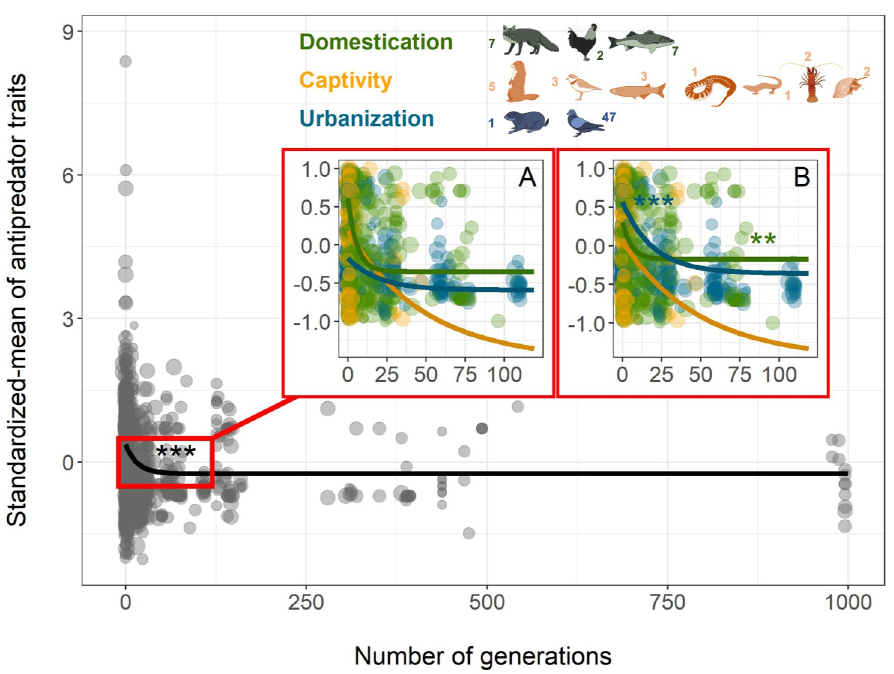
Fig 1. In multiple species, interactions with humans reduce the overall mean of antipredator traits over time, black line (all contexts). (A) Lines correspond to the best inverse model fitting the data using the cma-es function. (B) Lines correspond to the best inverse model with the outputs (slopes and intercepts) of the MCMCglmm model for the mean. Dot size is proportional to the log-transformed number of replicates used in each study. “ ��� ” indicates significant p -value < 0.001 and “ �� ” significant p -value < 0.01 of the inverse slopes with the MCMCglmm model (S1 Table). The number associated with each animal indicates the number of species in each of the following taxa: Mammals, Birds, Reptiles, Fish, Amphibians, Arthropods, and Mollusks. All data and R code supporting the figure are available in S1C Data. Species design: Pierre Lopez (MARBEC). cma-es, covariance matrix adapting evolutionary strategy; MARBEC, Marine Biodiversity, Exploitation and Conservation; MCMCglmm, Markov chain Monte Carlo generalized linear mixed model.